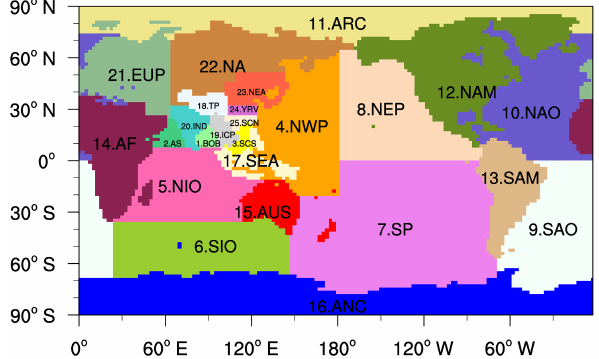
Figure 1. Moisture source regions: the regions are denoted